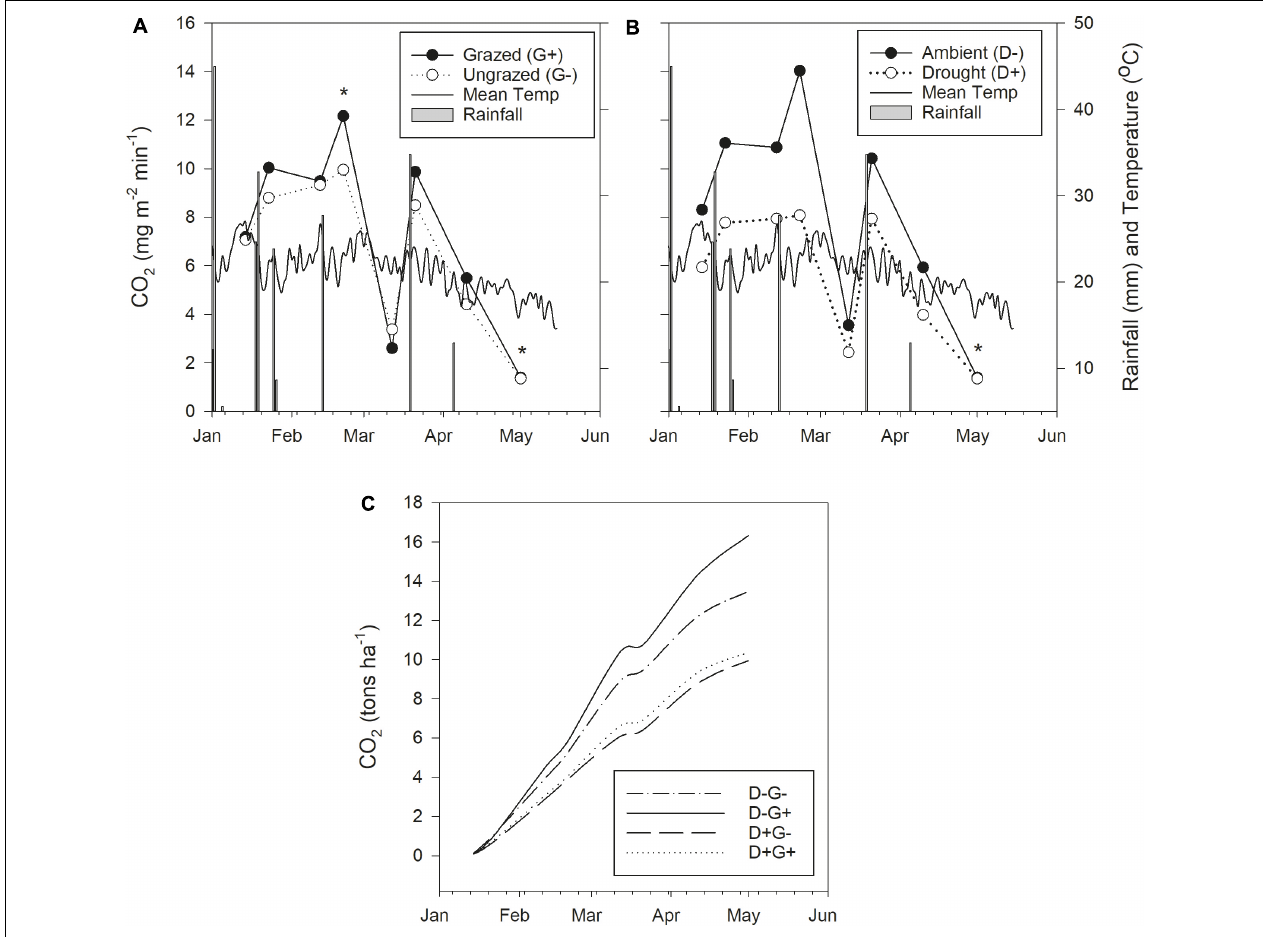
FIGURE 3 | Effect of grazing and drought on CO 2 fluxes. (A) Comparison of CO 2 fluxes between grazed and ungrazed plots; (B) comparison of CO 2 fluxes between plots under drought and ambient rainfall conditions, and (C) cumulative CO 2 emissions over the measurement period in the four treatments (D–G– ambient rainfall with grazing exclusion; D– G+ ambient rainfall with moderate grazing; D + G– drought with grazing exclusion; and D + G + drought with moderate grazing).